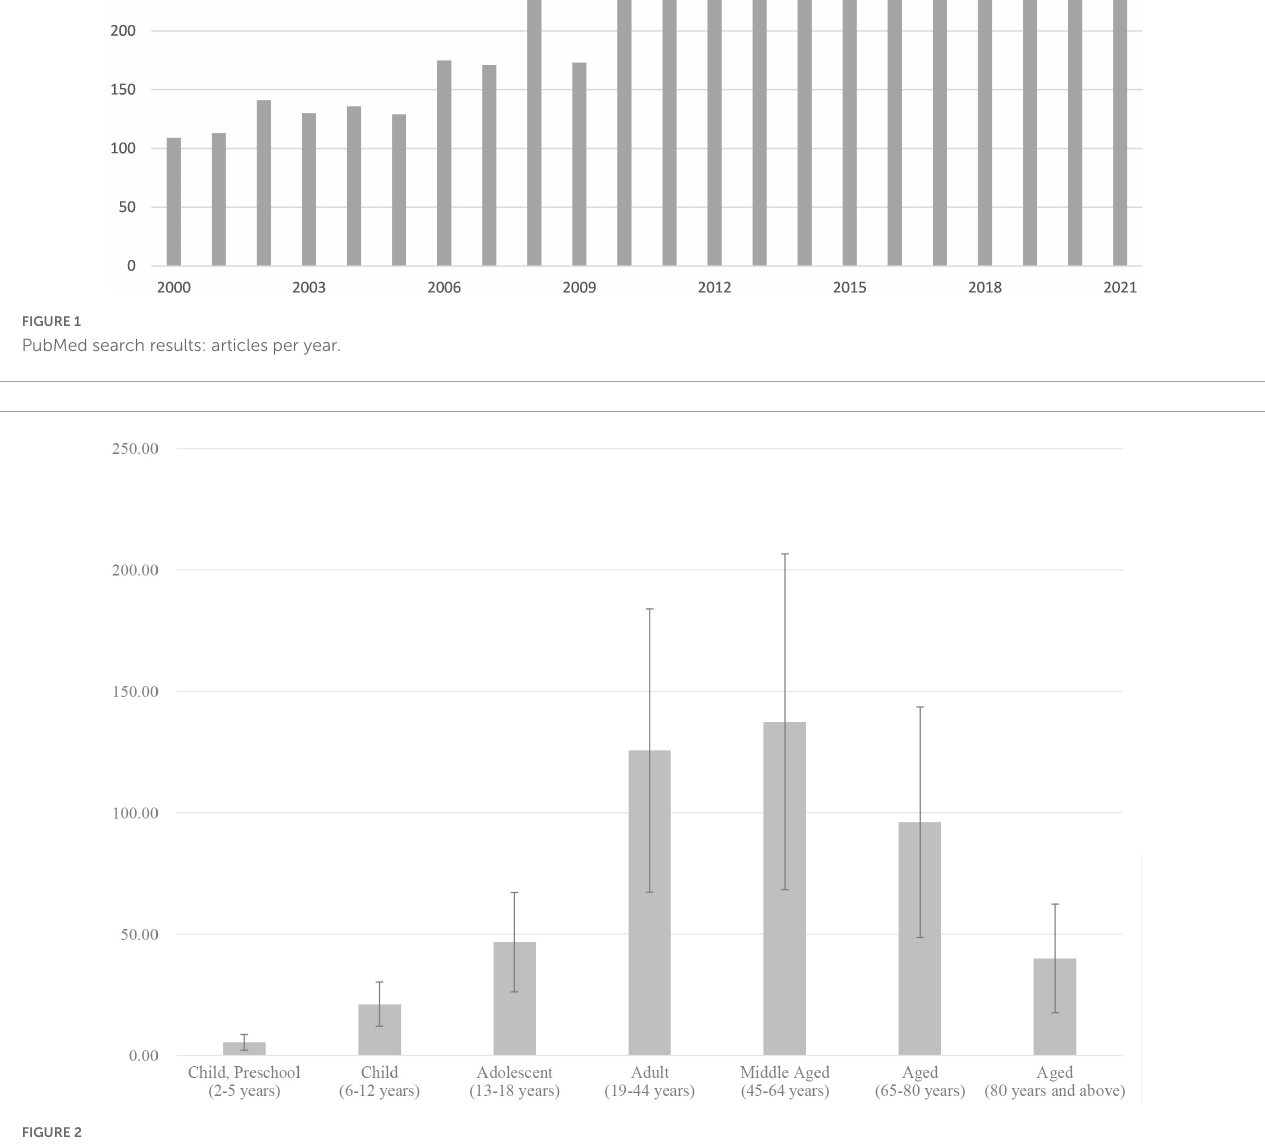
FIGURE2 Annual output of literature, broken down by age